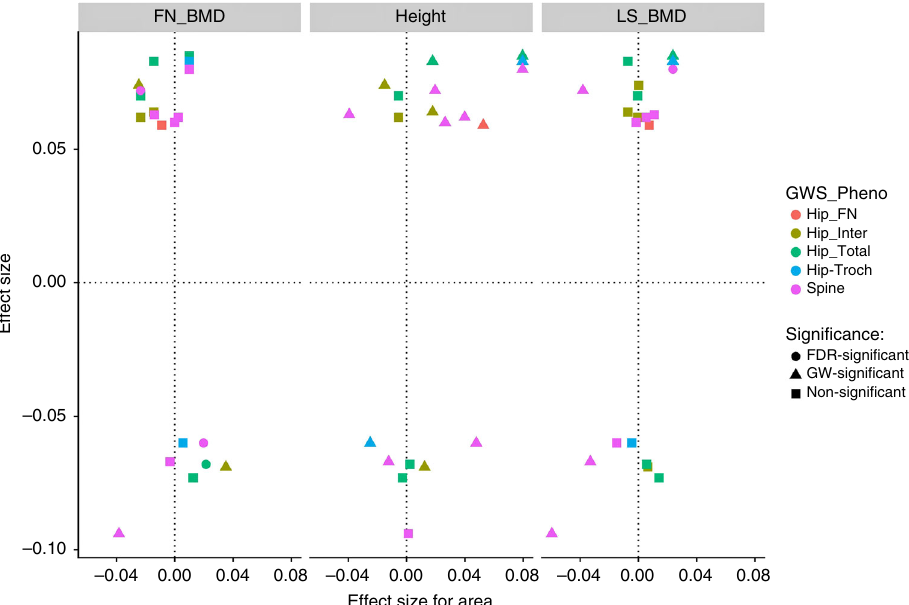
Fig. 4 Effect on DXA bone area measures, height and bone mineral density. The effect on area measures are plotted on the X -axis and the effect on reported height variants from the GIANT consortium 1 , and reported femoral neck BMD (FN_BMD) and lumbar spine BMD (LS_BMD) variants from the GEFOS consortium 13 are plotted on the Y -axis. Effects are in in standard deviations. The color of the dots/triangles/squares indicate the site of the DXA area measure, and the shape indicates the strength of association with height, and hip and lumbar spine BMD; squares, non-signi fi cant, dots, signi fi cant after correcting for FDR, and triangles, genome wide signi fi cant. Source data are provided as a Source Data fi